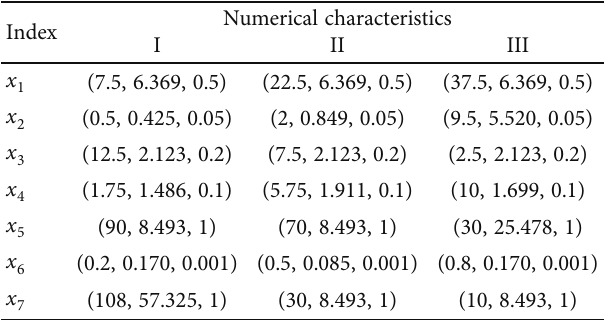
Figure 4: Comparison of weights determined by the analytic hierarchy process, the entropy weight method, and the comprehensive weight method. Table 4: Numerical characteristics of each index belonging to each risk